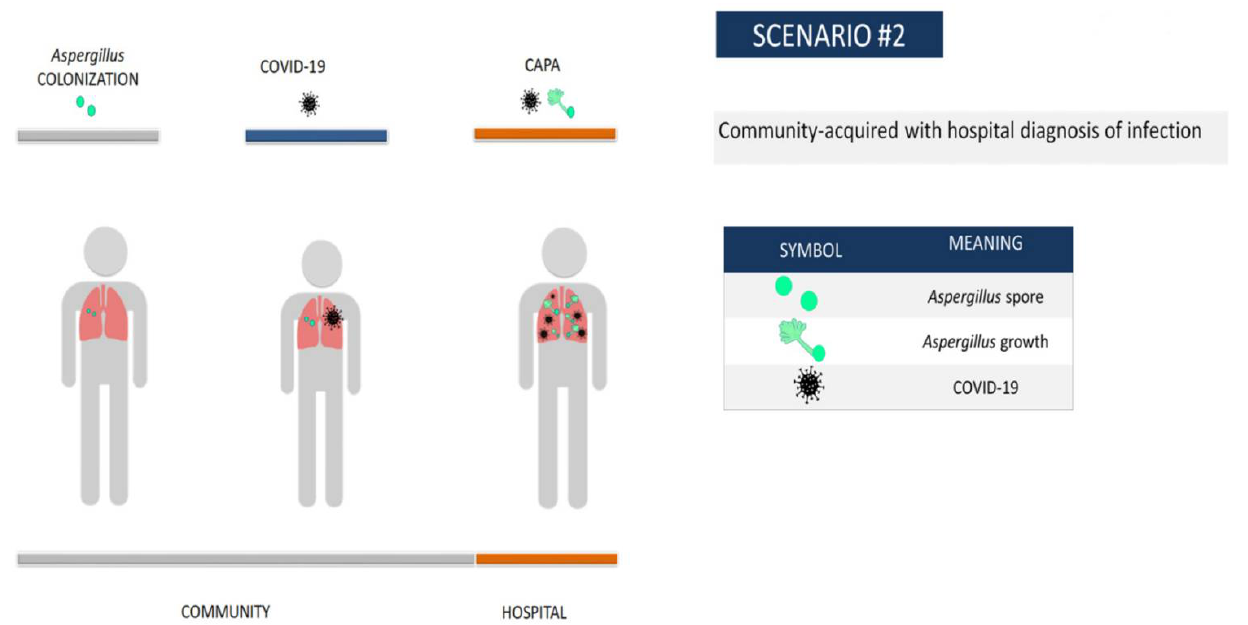
Figure 2. Scenario 2—Community Aspergillus colonization, community COVID disease, and hospital diagnosis of community acquired-CAPA.